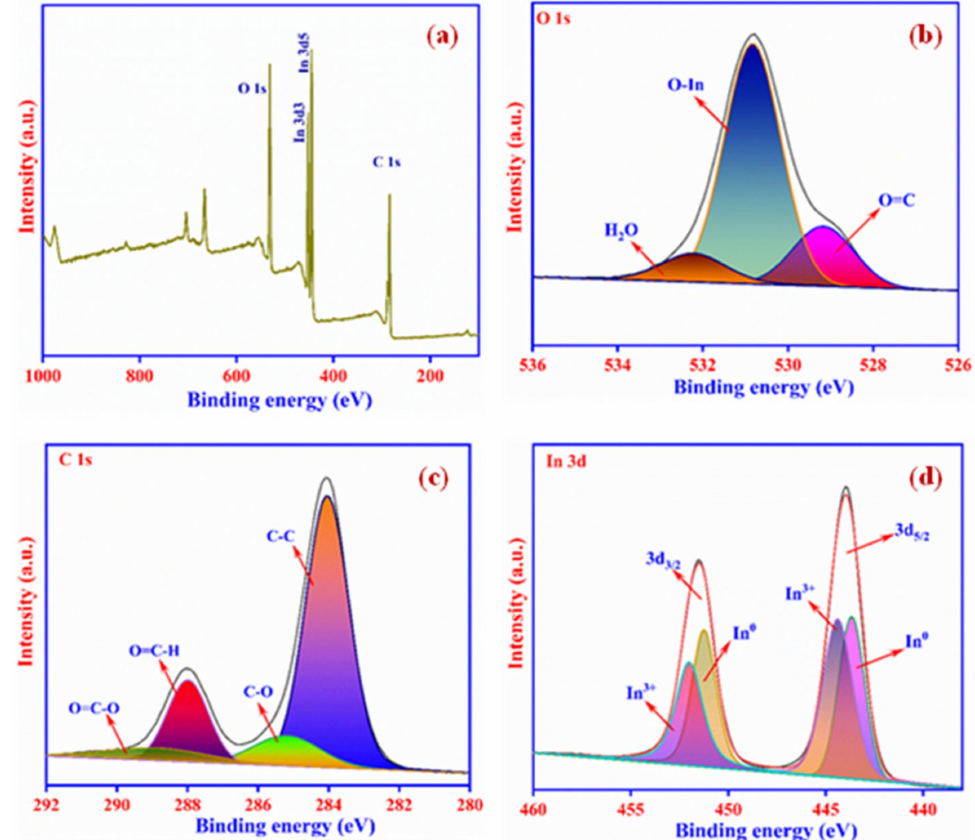
Figure 5. XPS survey spectrum of In 2 O 3 -MF ( a ); XPS spectra and deconvolution of O 1s ( b ); C 1s spectra ( c ); and In 3d spectra ( d